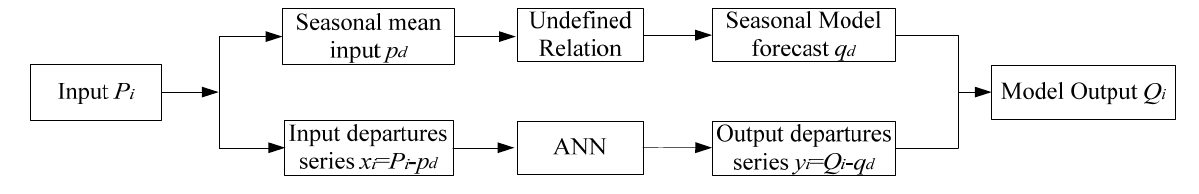
Figure 1. Schematic diagram of the NLPM-ANN